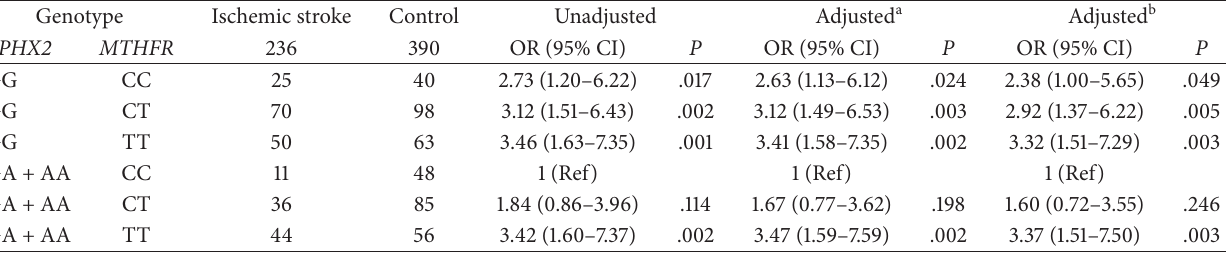
Table 4: Odds ratios and 95% confidence interval for the combined effect of MTHFR C677T and EPHX2 G860A polymorphism and ischemic stroke.